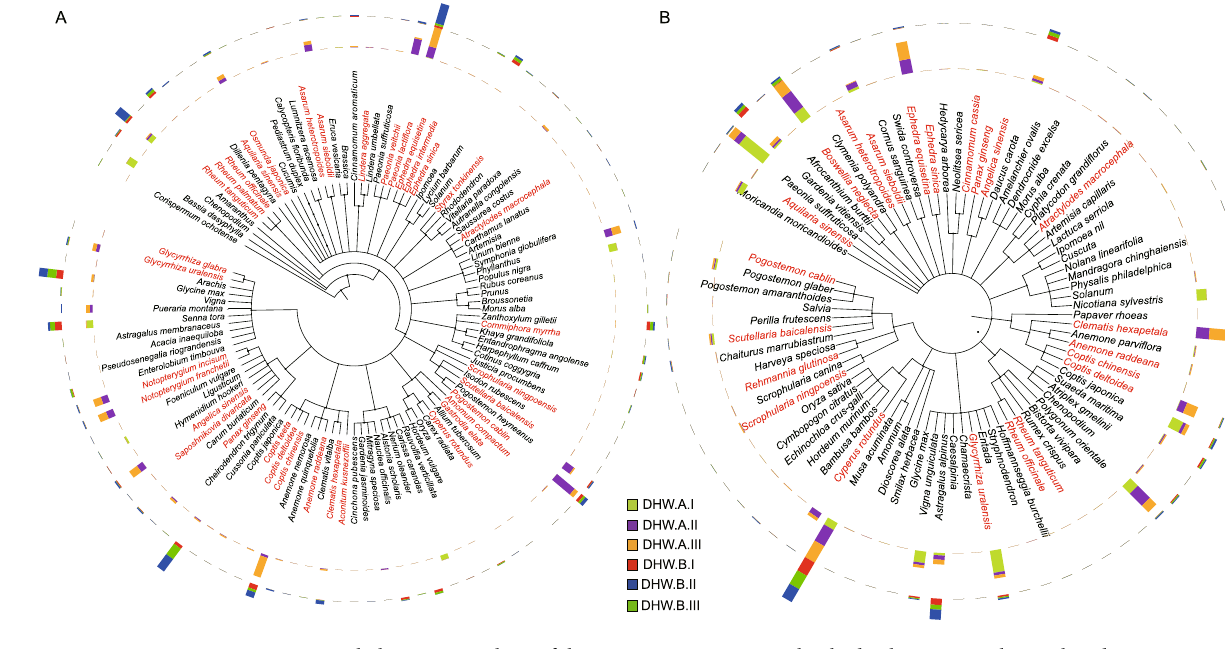
Figure 4. Phylogenetic analysis of the representative species that had at least 0.1% relative abundance in DHW samples. ( A ) Based on ITS2; ( B ) Based on trnL . The phylogenetic trees of species are visualized in iTOL (https:// itol. embl. de/). The branch in the tree depicts the taxonomic classification of species. The word marked in red means the prescribed herbal species, and the colorful bar means the average relative abundance of species across the three batches from the two manufacturers ( A , B ). NJW.A